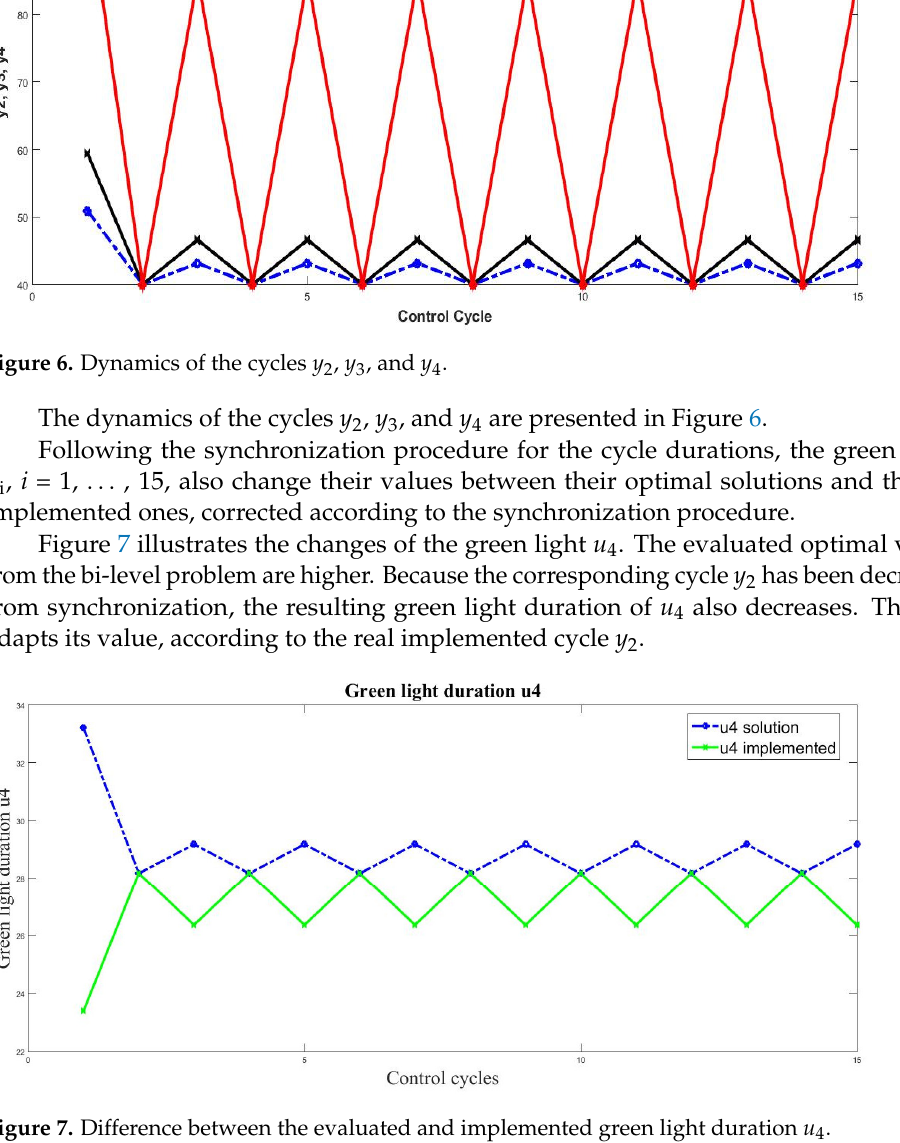
Figure 8. Difference between the evaluated and implemented green light duration u 6 . Figure 9. Difference between the evaluated and implemented green light duration u 8 .